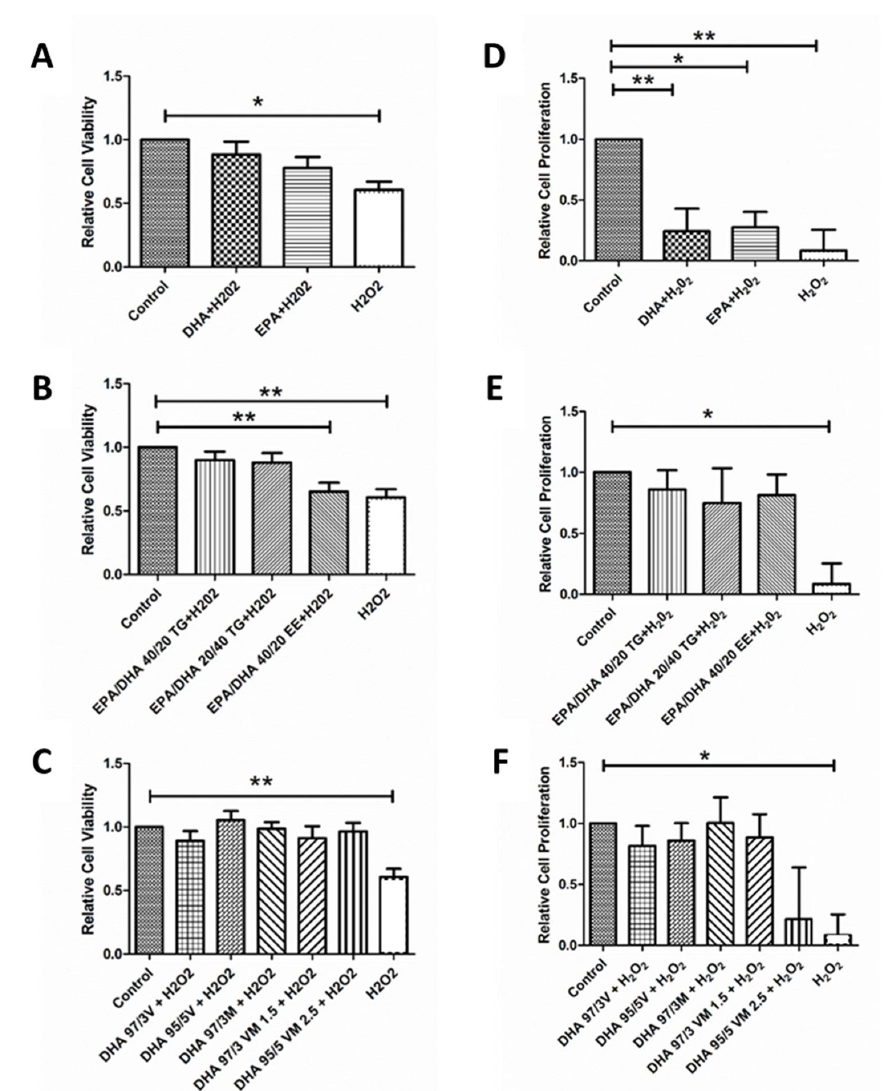
Figure 3. Graphs showing relative cell viability ( A–C ) and proliferation ( D – F ) results for